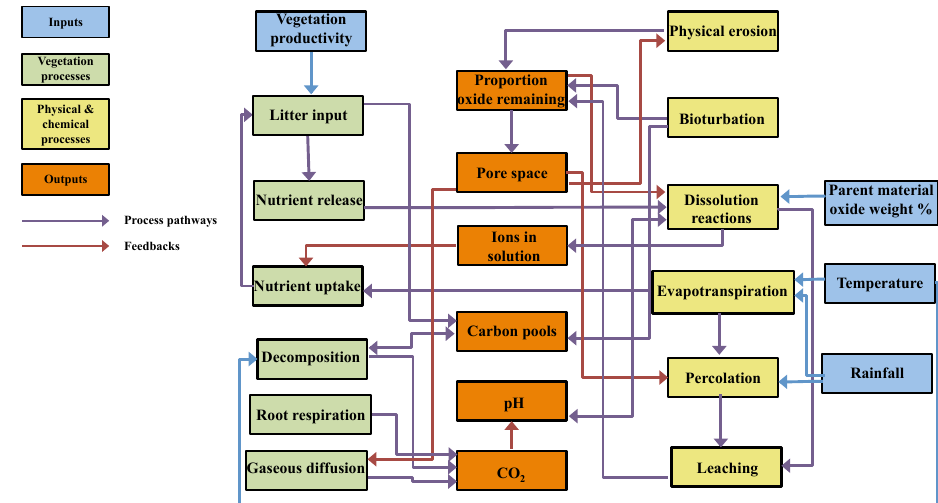
Figure 1. Diagram of the major processes, inputs and outputs of the soil profile